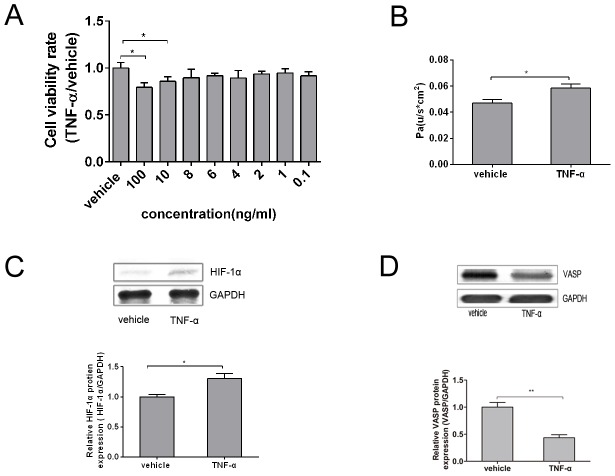
TNF-α inhibited A549 cell viability, increased paracellular permeability, HIF-1α expression and decreased VASP expression.(A) Cells were evenly seeded in 96-well plates at a density of 103–104 cells per well (200 µL per well) and then incubated with TNF-α (0 – 100 ng/mL) for 24 hours. The cell viability rates were examined using an MTT assay, as shown in the bar graph. Compared with 0 ng/mL TNF-α (vehicle control), the stimulation with 0.1–8 ng/mL TNF-α did not affect cell viability (p>0.05). In contrast, 10 ng/mL and 100 ng/mL TNF-α significantly inhibited the viability of A549 cells (*p<0.05) in a dose-dependent manner with reduction rates of 14.3% and 20.7%, respectively. (B) 200 µL of 1×105/mL A549 cell suspension was seeded in the upper chamber of a Transwell that was previously covered with 1% gelatin until 80% confluence. After the well was pre-incubated with 10 ng/mL TNF-α for 24 hours, the Pa was determined according to the rate of fluorescence intensity of FITC-Dextran in the upper and lower chambers by a multifunctional microplate reader, as shown in the bar graph, TNF-α treatment increased Pa by 23.4% compared with the control group. (C) A549 cells were exposed to 10 ng/mL TNF-α for 24 hours, and the total protein of HIF-1α was then extracted. Western Blotting analysis was then used to evaluate the total protein level with each antibody against total HIF-1α, as shown in the bar graph, which represents a graphical representation of the relative density of HIF-1α to GADPH. TNF-α dramatically increased HIF-1α expression by 30.7% compared with the vehicle control. (D) A549 cells were exposed to 10 ng/mL TNF-α for 24 hours, and the total VASP protein was then extracted. Western Blotting analysis was then used to evaluate the total protein level with each antibody against total VASP, as shown in the bar graph. TNF-α inhibited VASP expression by 56.6% compared with the vehicle control. GAPDH served as a loading control; representative blots from three independent experiments with similar results are shown. The relative protein expression levels obtained for HIF-1α or VASP/GAPDH were used in bar graphs C and D. The test was repeated three times with identical results. The data are presented as the mean ± SEM. *p<0.05, **p<0.01 vs. vehicle control.